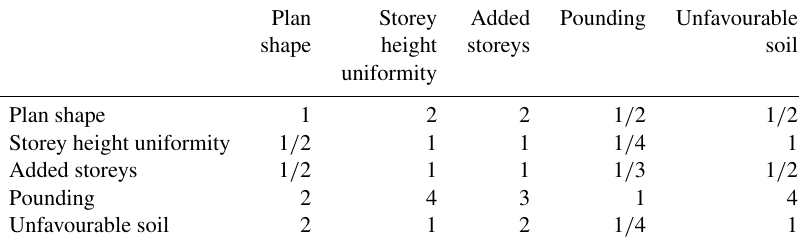
Table A3. Judgement matrix adopted for the calibration of the in-plane behaviour weights.